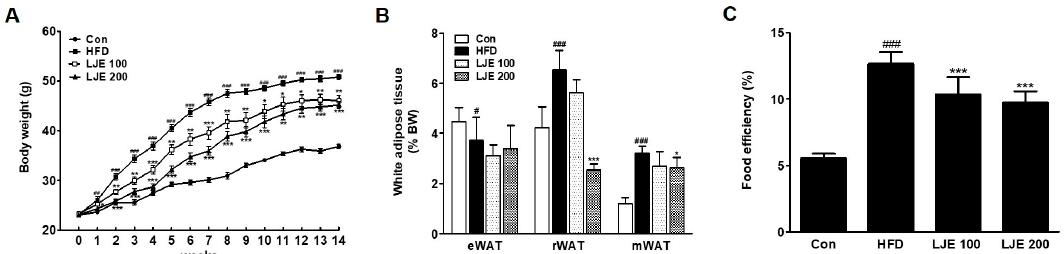
Figure 5. Effects of LJE on the body weight and visceral white adipose tissues in high-fat diet (HFD)-fed mice. ( A ) Body weight changes; ( B ) Visceral white adipose tissue; ( C ) Food efficiency. Con, normal control diet; HFD, high-fat diet; LJE 100, HFD plus LJE (100 mg/kg, peroral); LJE 200, HFD plus LJE (200 mg/kg, peroral). Data represent means ± SEM ( n = 8). # p < 0.05, ## p < 0.01, ### p < 0.001 vs. Con; * p < 0.05, ** p < 0.01, *** p < 0.001 vs. HFD.